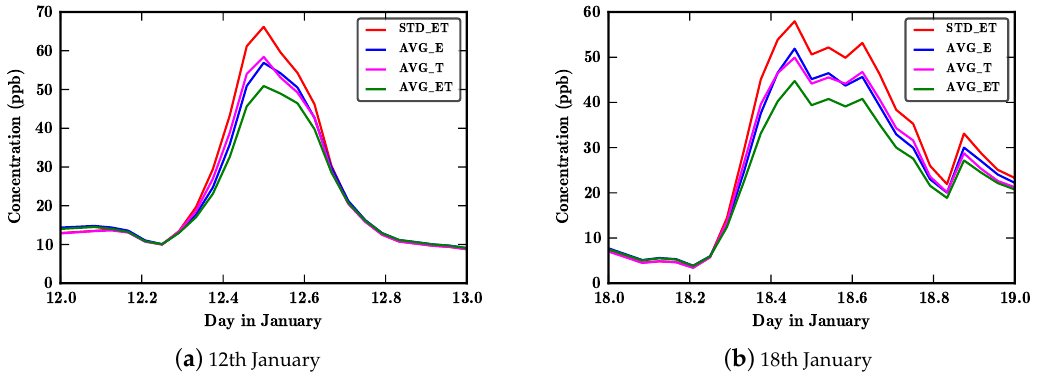
Figure 12. Timeseries of simulated O 3 from the 17 sites for various scenarios from 7 to 20 January 2013.